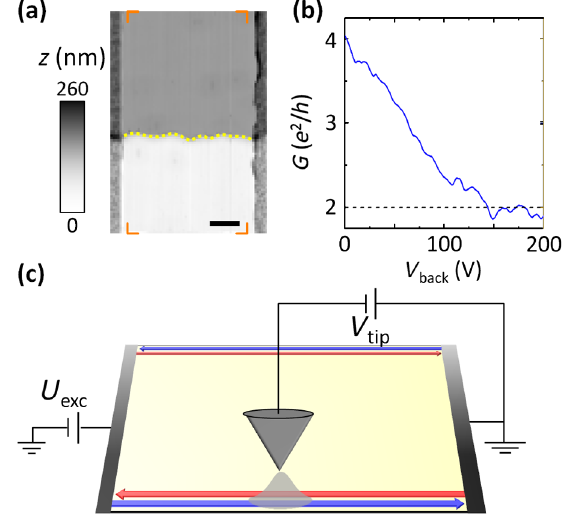
FIG. 1. (a) In situ atomic force microscopy scans (scale bar 1 (cid:1) m ) allow for precise alignment of the tip to the device. The mesa extends upward from the dotted yellow line. The grainy areas at the left and right edges, respectively, are the Ohmic contacts to the quantum well. The orange markers demarcate the scan window used for the conductance maps in Figs. 2 and 3. (b) A back-gate electrode is used to tune the device into the QSH regime with G (cid:4) 2 e 2 =h . (c) Illustration of the experimental configuration for SGM studies of the QSH